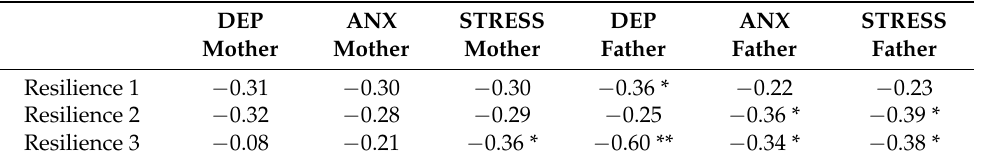
DEP ANX STRESS DEP ANX STRESS Mother Mother Mother Father Father Father